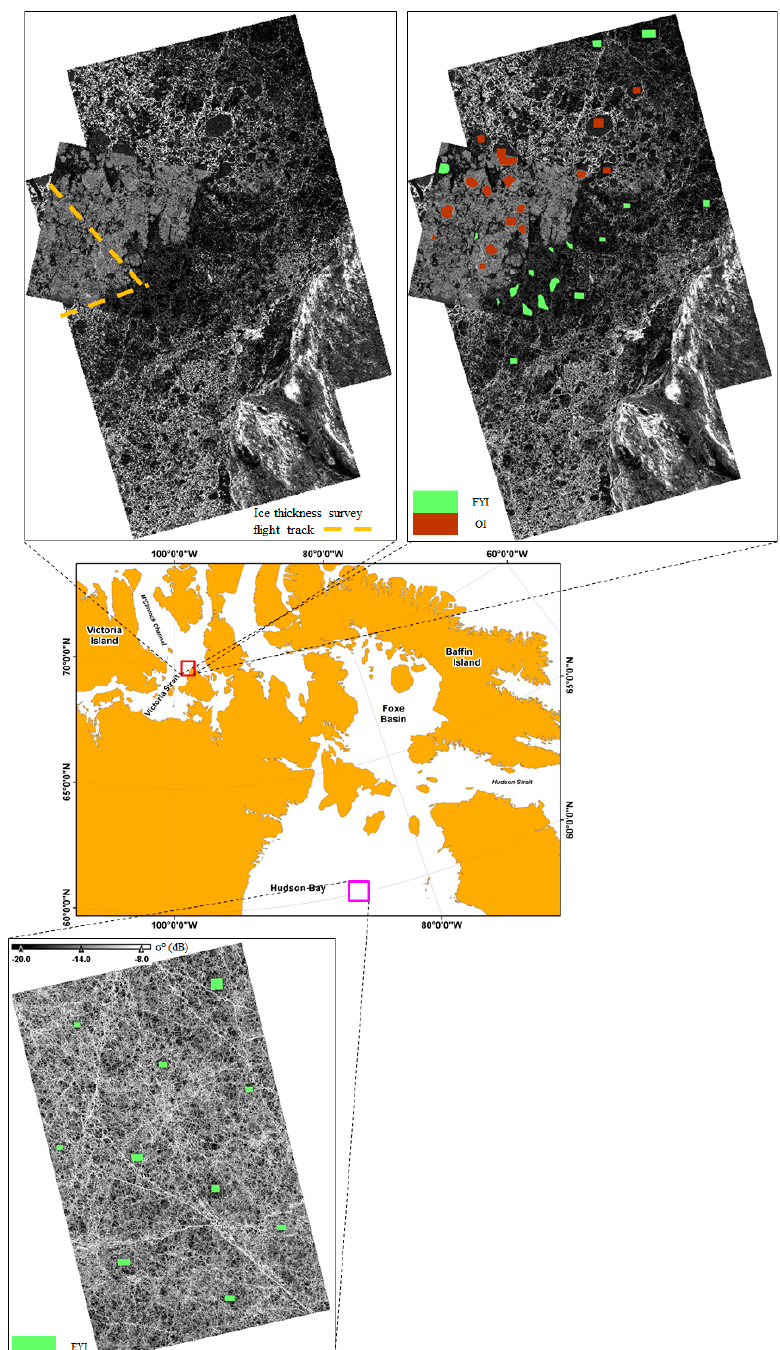
Figure 1. Location of the study area (red square) in the Canadian Arctic Archipelago (CAA). Also shown are the total backscattering power ( SPAN ) of the RADARSAT-2 image and the two Advanced Land Observing Satellite-2 (ALOS-2) images with the ice thickness survey flight track and the selected First Year Ice (FYI) (green) and Old Ice (OI) (brown) samples. SPAN of ALOS-2 image over Hudson Bay is shown with the location (magenta square) and the selected FYI samples.